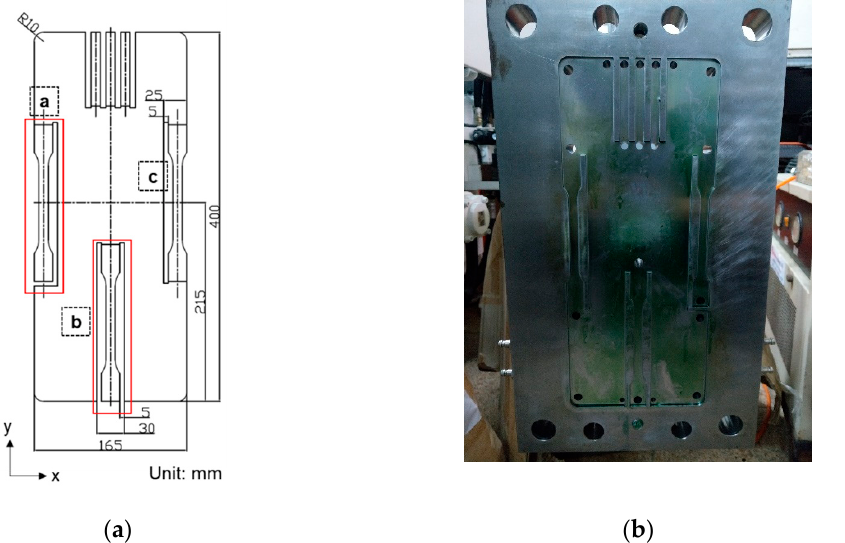
Figure 3. Schematic of tensile samples: ( a ) diagram of the sample designs (ISO 527-2 at a thickness of 3 mm) and ( b ) diagram of the mold cavity of the samples.